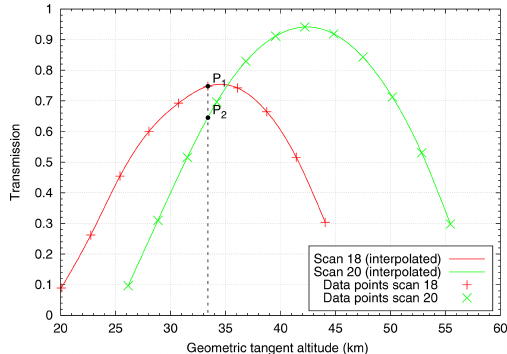
Figure B1. Bending angle fit. See text for